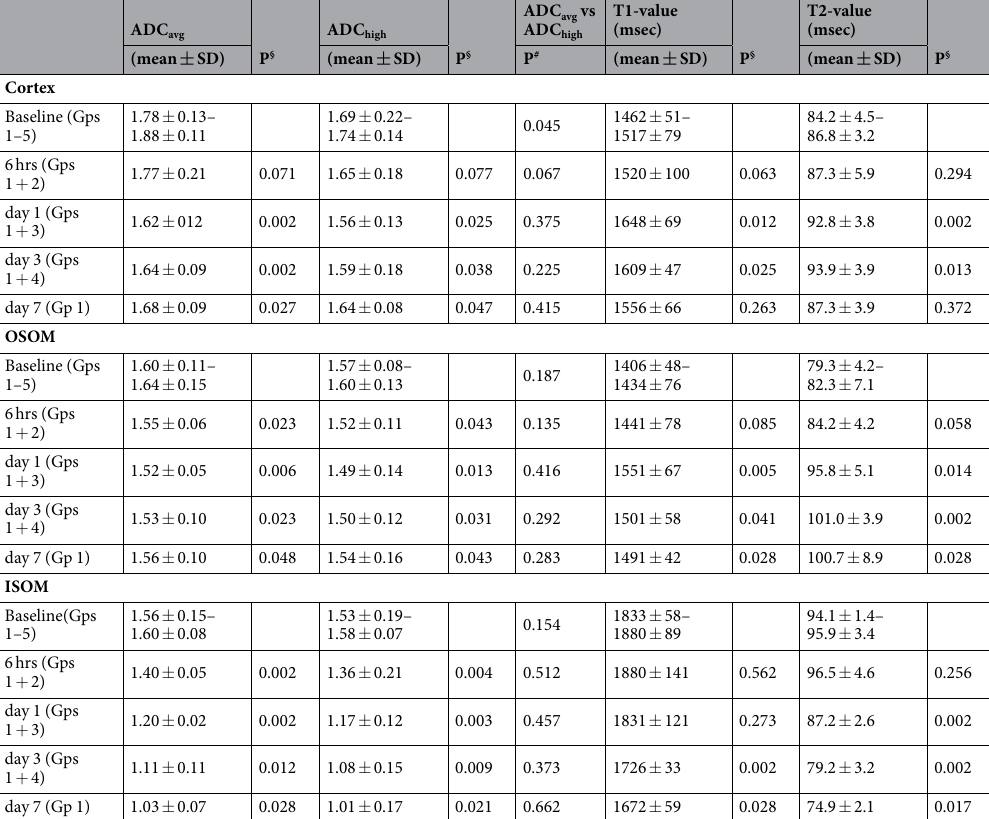
Table 1. Mean apparent diffusion coefficient (ADC), T1-values and T2-valves changes of the rats before and after acute ischemic/reperfusion injury of the kidneys at different time points. ADC = apparent diffusion coefficient (x10 − 3 mm 2 /sec), ADC avg = average ADC of all b values, ADC high = ADC of high b values, Gp = group, hrs = hours, OM = outer medulla, OS = outer stripe, IS = inner stripe, Gp 5 = sham control (baseline MRI then sacrificed at day 7), Wicoxon signed-rank test ( § compared with its own baseline values and # compared ADC avg with ADC high , significance at P < 0.05).